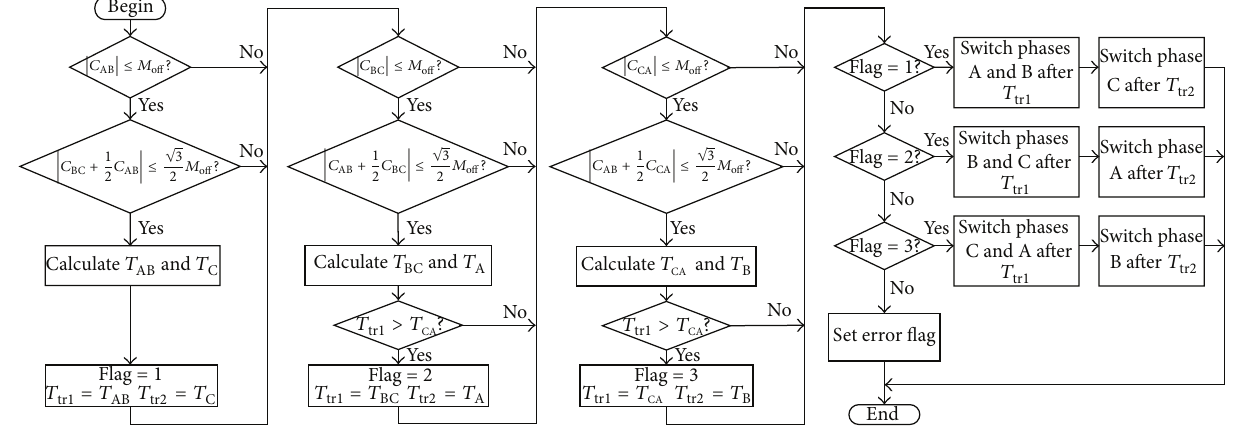
Figure 8: Control flowchart to transfer the alternate